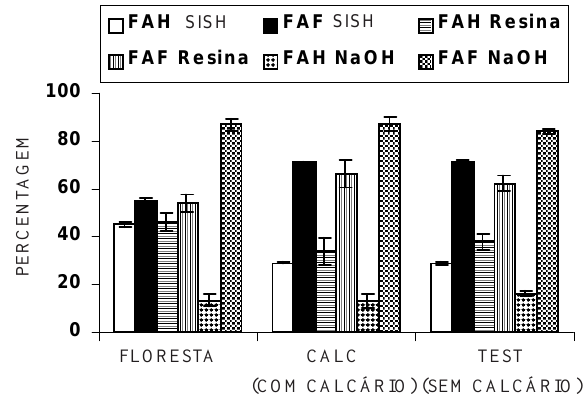
Figura 3. Proporções de frações ácidos húmicos (FAH) e frações ácidos fúlvicos (FAF) sob influência do uso e manejo do LE e de métodos de extração e fracionamento de substâncias húmicas (SH). Legenda: FAH e FAF SISH: proporções de FAH e FAF presentes em SH extraídas com NaOH e fracionadas pelo método proposto pela SISH; FAH e FAF Resina: proporções de FAH e FAF presentes em SH extraídas pela resina Chelex e fracionadas via CETAE; FAH e FAF NaOH: proporções de FAH e FAF presentes em SH extraídas com NaOH e fracionadas via